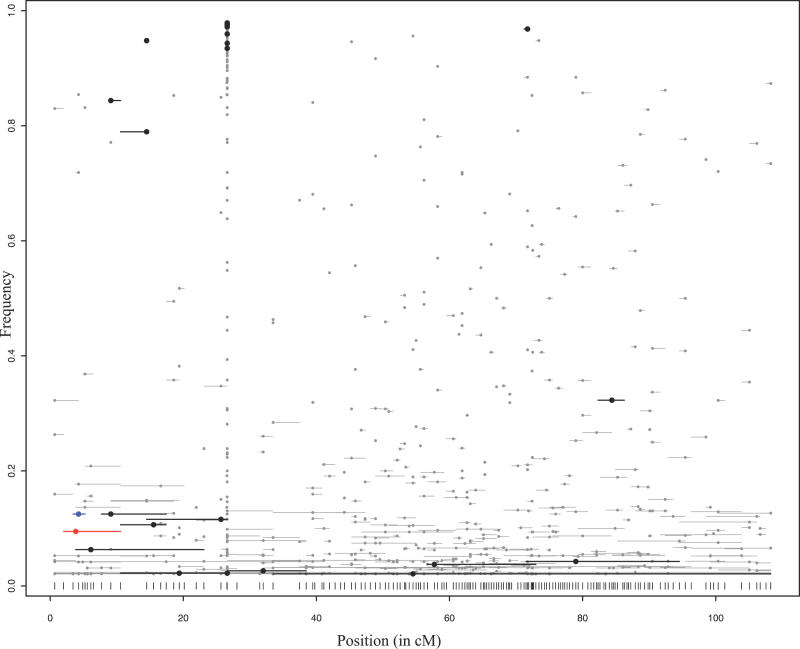
Haplotype Sharing of Alleles Plotted by Frequency along Chromosome 4Points represent the location of alleles, while corresponding lines indicate the average length of haplotype identity flanking the allele. Those alleles present in the upper 99th percentile are indicated in black. The
fri
Col allele and associated haplotype are indicated in red. This haplotype is over 600 kb, or 8 cM, long. The allele marking
fri
Ler and its associated haplotype are indicated in blue. Only those alleles with a positive score are plotted. Locations of the sequence fragments are indicated at the bottom of the figure.